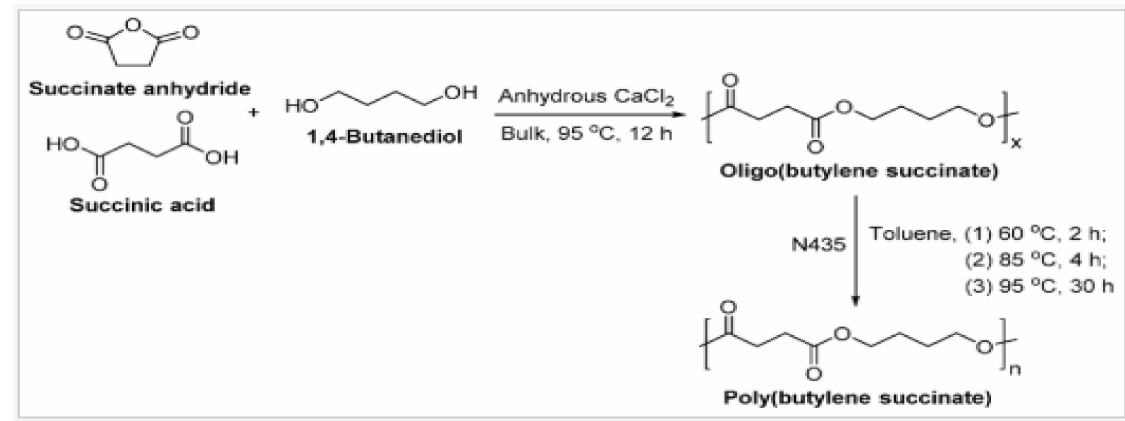
Figure 6. Synthesis of poly(butylene succinate) via the N435-catalyzed co-polymerization of succinic acid and 1,4-butanediol with succinate anhydride [50]. Adapted with permission from Azim et al. (2006).